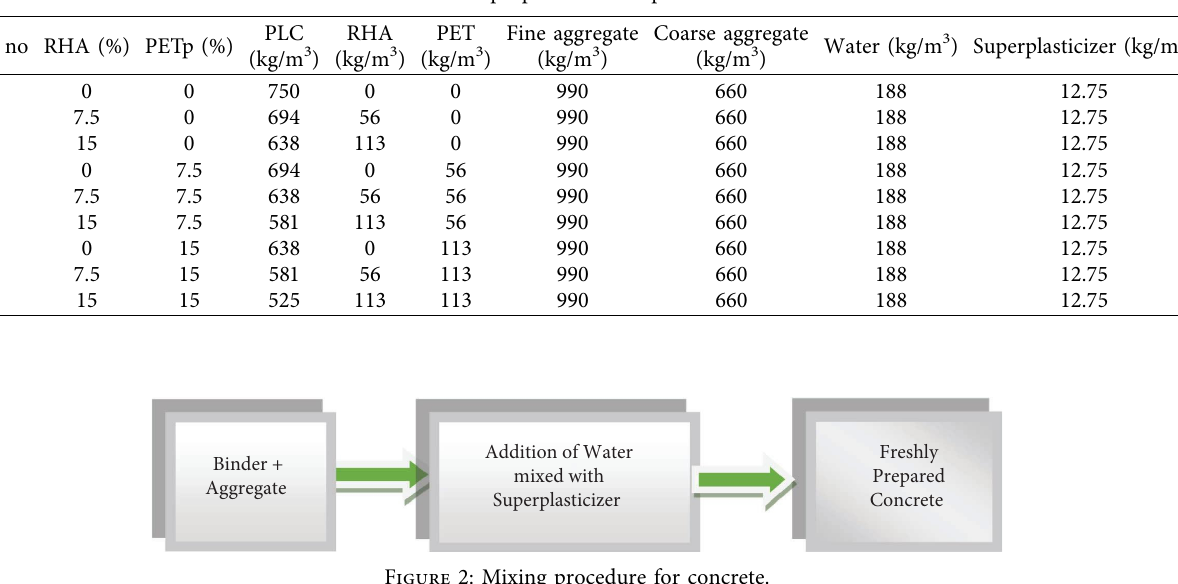
Figure 1: Conversion process of PET bottles to powder. Table 1: Mix proportion for experimental run.